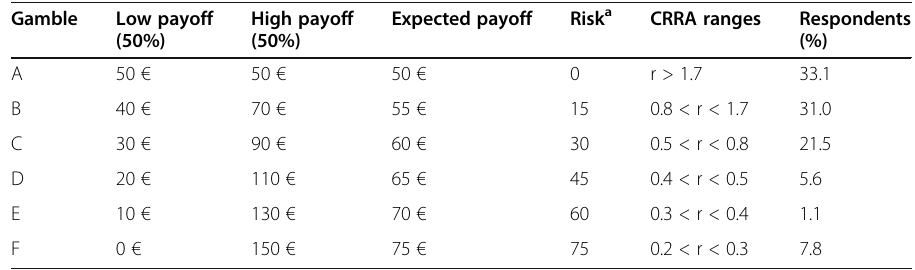
Table 4 Lottery: CRRA ranges and relative percentage of respondents Gamble